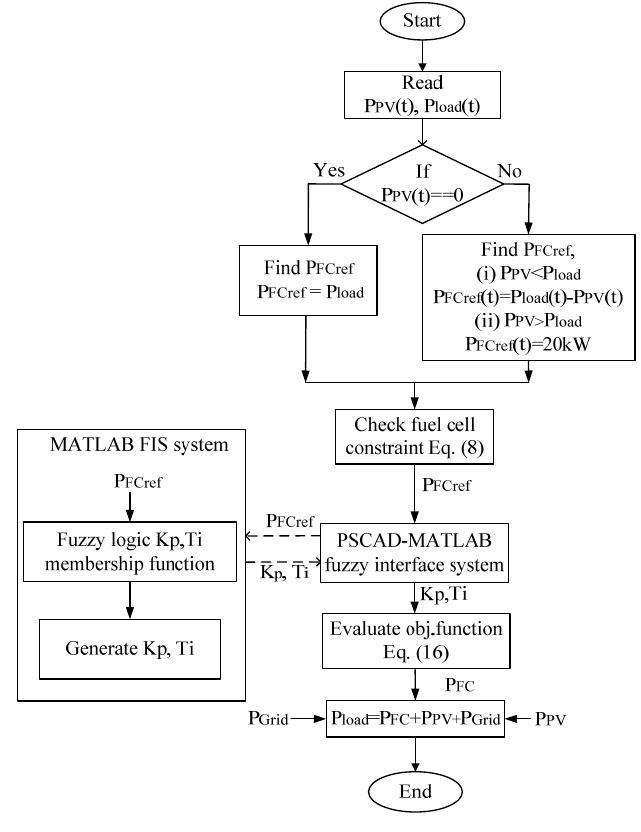
Figure 4. Control algorithm for power management system.